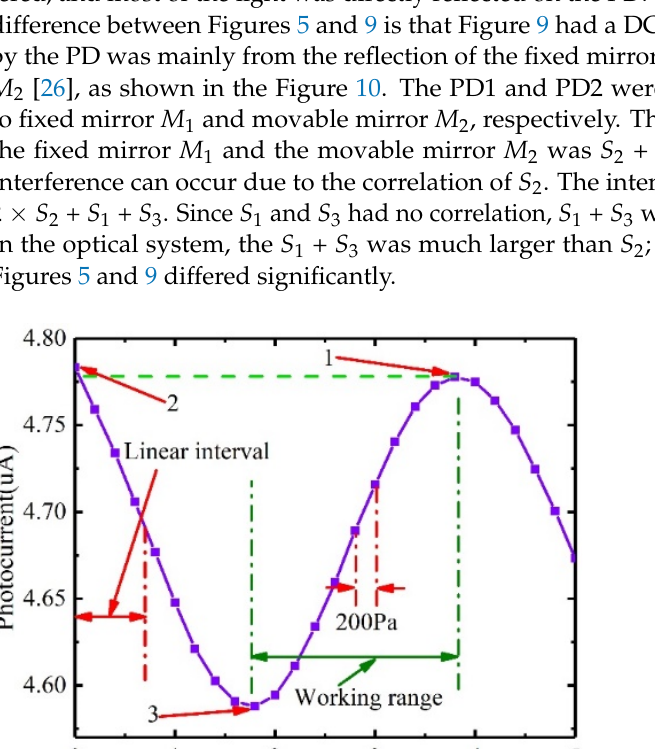
Figure 8. The pressure sensor performance test platform.